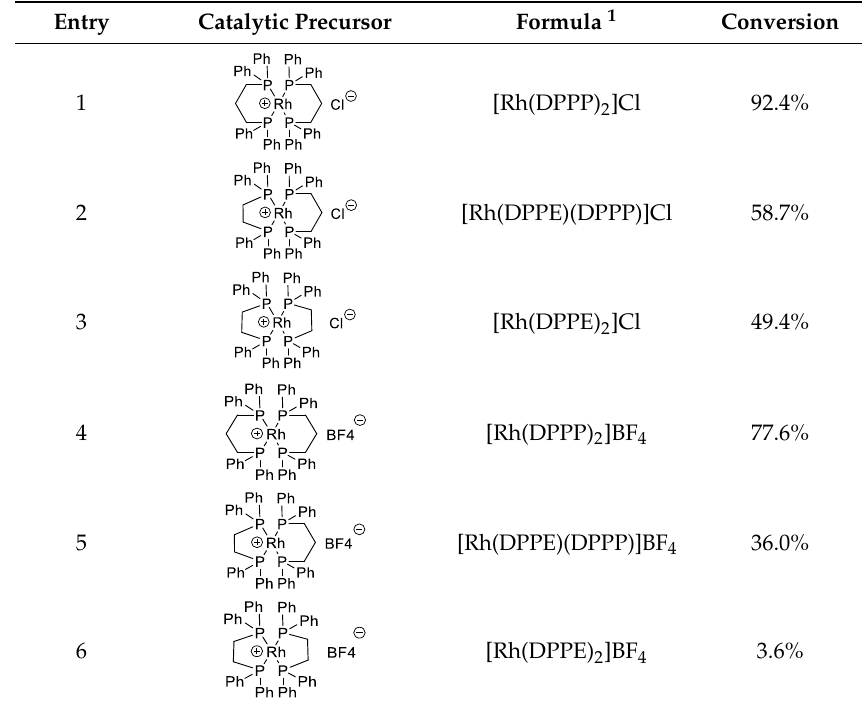
Table 2. Reduction of acetophenone in the presence of refluxing 2-propanol and t BuOK mediated by